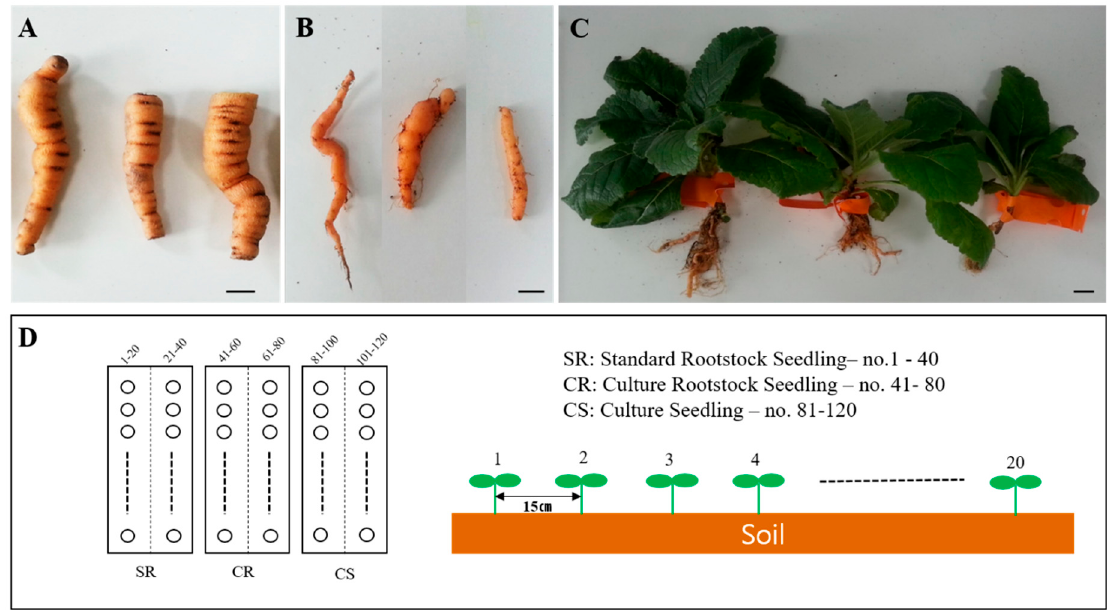
Figure 6. Seed plots for the three types of R. glutinosa seedlings and field experiment design. ( A ) SR (standard rootstock seedling). ( B ) CR (culture rootstock seedling). ( C ) CS (culture seedling). Scale bar, 1.0 cm. ( D ) Planting intervals and the number of R. glutinosa seedlings planted.